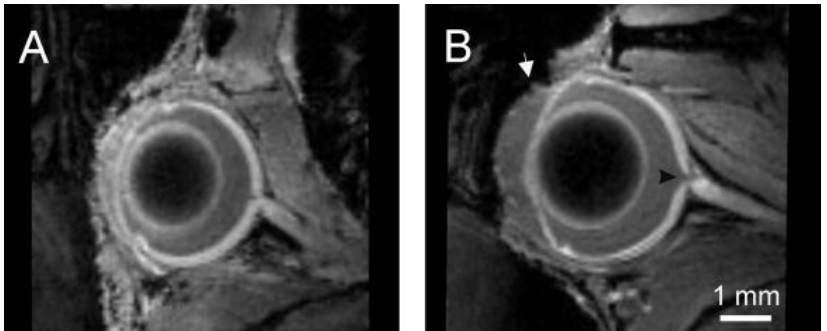
Figure 1. Representative T1-weighted magnetic resonance images of the eyes in 10-month-old C57BL/6 ( A ) and DBA/2J ( B ) mice 24 h after administration of a manganese contrast agent. The black arrowhead indicates the optic disc cupping (black arrowhead). White arrow—enlarged anterior chamber of the eye in DBA/2J.